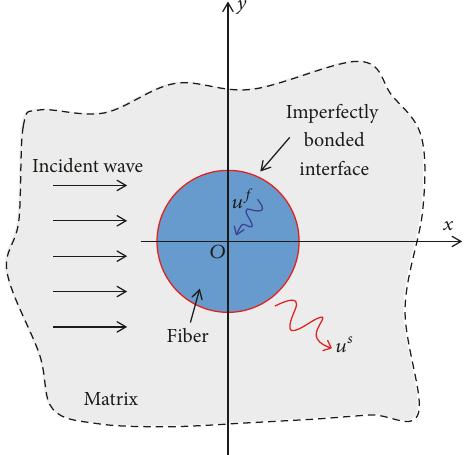
Figure 10: Scattering of a plane SH-wave by a cylindrical fiber with a pure imperfectly bonded